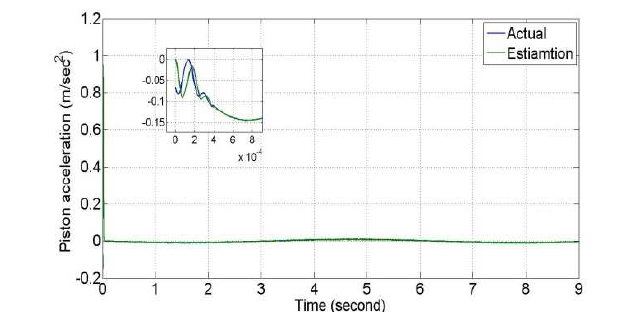
under (cid:157)(cid:5) ¡